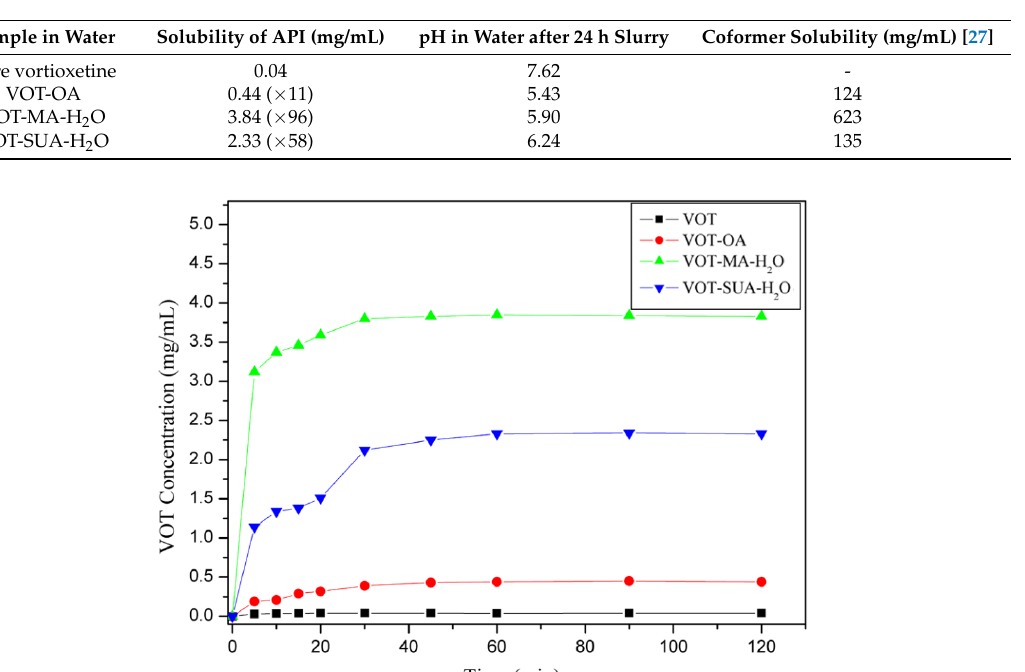
Figure 8. Powder dissolution profiles of VOT, VOT-OA, VOT-MA-H 2 O, and VOT-SUA-H 2 O salts at different time points in pure water at 37 °C.